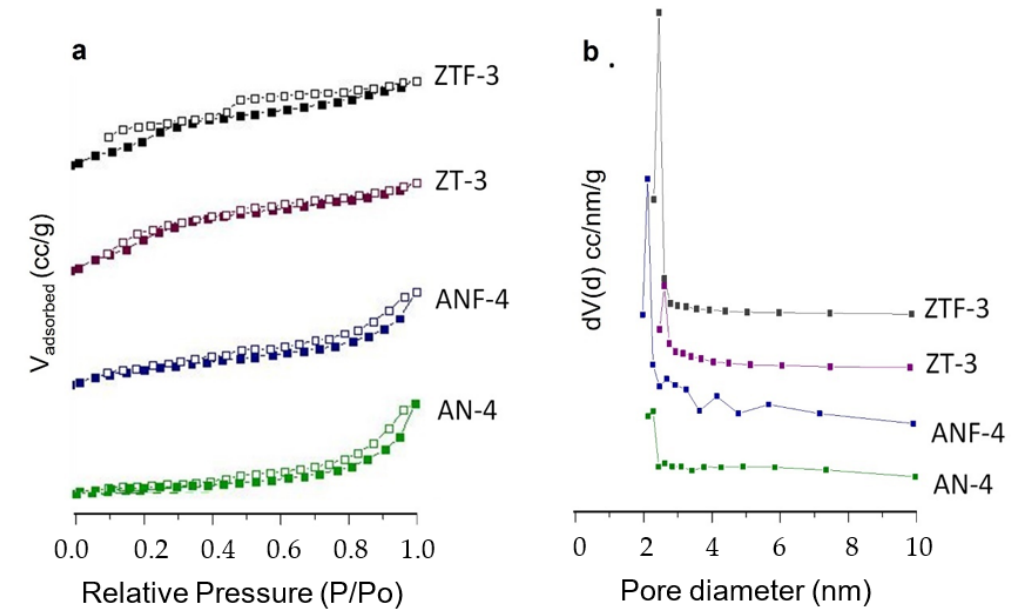
Table 2. Textural properties of aluminosilicate and ZSM-5